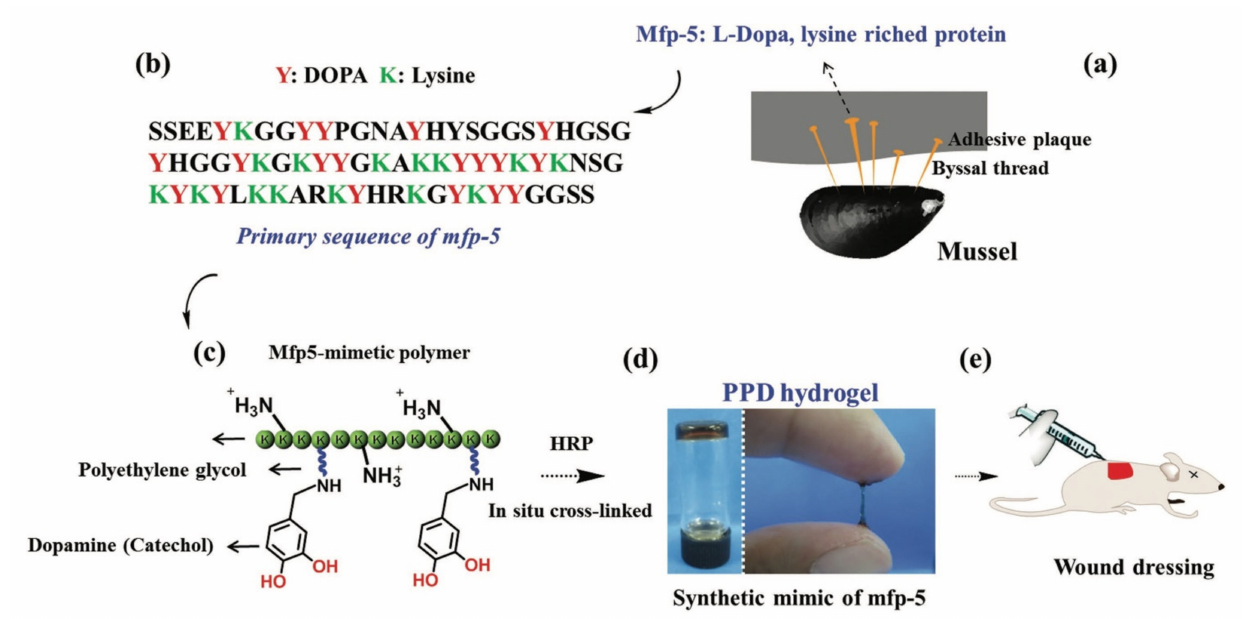
Figure 16. ( a ) Diagram of mussel attachment, polylysine is contained with the plaque; ( b ) the primary amino acid sequence of mfp-5; ( c ) Conjugation of dopamine onto the mfp-5 mimetic polymer; ( d ) Horseradish Peroxidase (HRP) crosslinking of the polymer to form a hydrogel; and ( e ) application of polymer onto a mouse wound model. Used with permission from a report by Wang et al. [333] © 2021 WILEY-VCH Verlag GmbH & Co. KGaA,